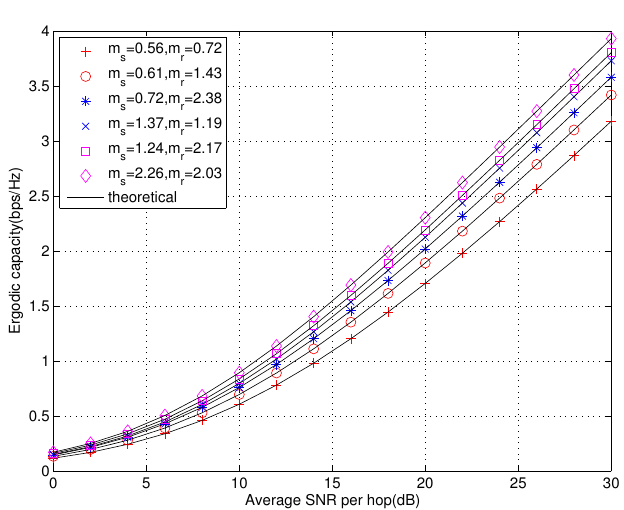
Figure 4. Comparison of the ergodic